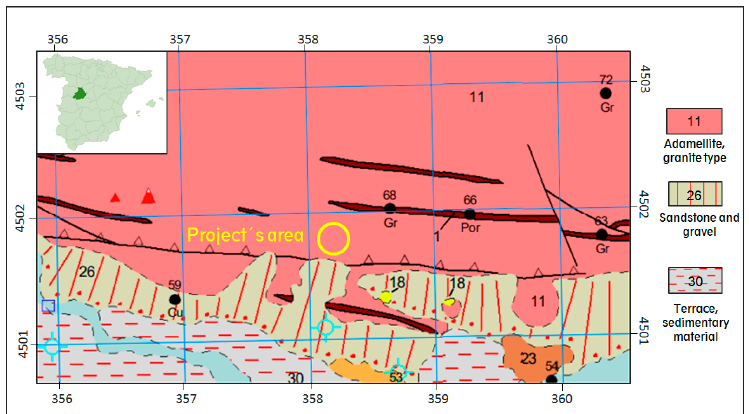
Figure 10. Location and geological information of the borehole and geothermal system, UTM coordinates (10 3 ).